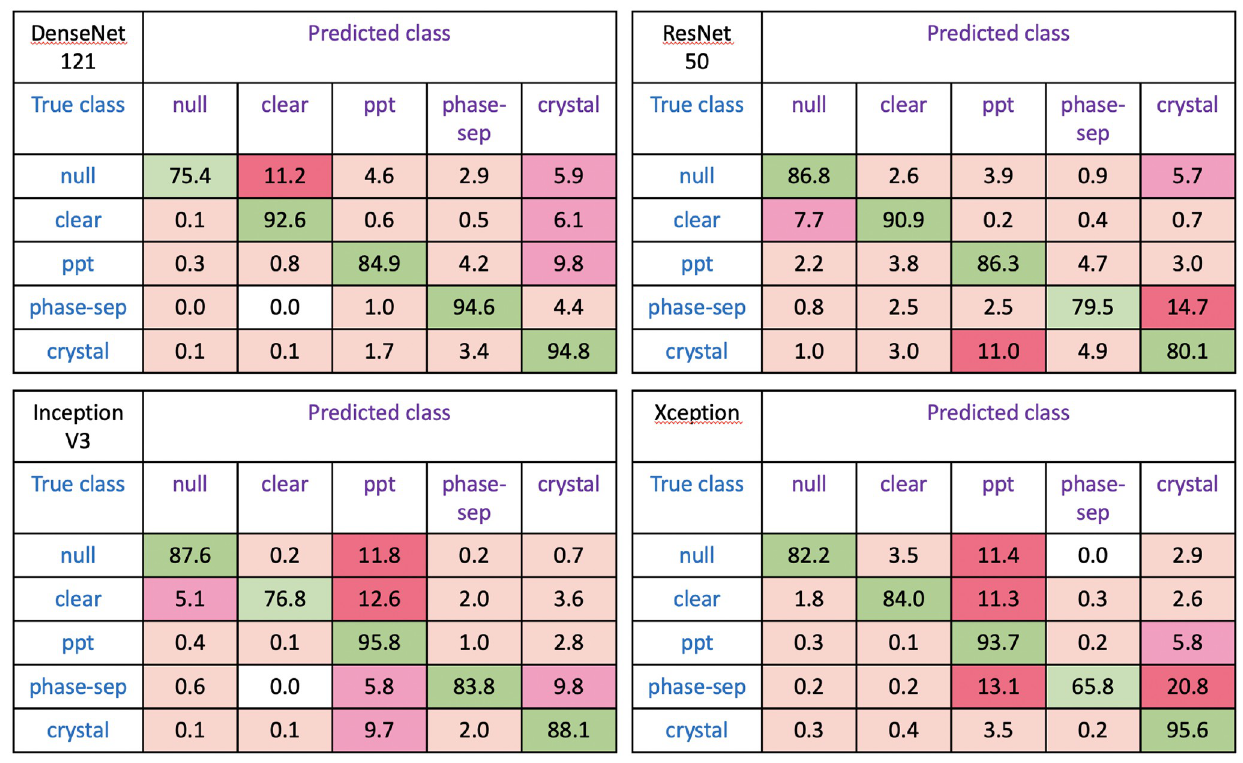
Fig 5. Confusion matrices showing the results obtained with the four different classifiers for Test sets 2 and 3 combined. The number of classes has been reduced for easier comparison by combining light precipitate and heavy precipitate as just precipitate and the three classes crystalline, optimisable and shootable as crystal .